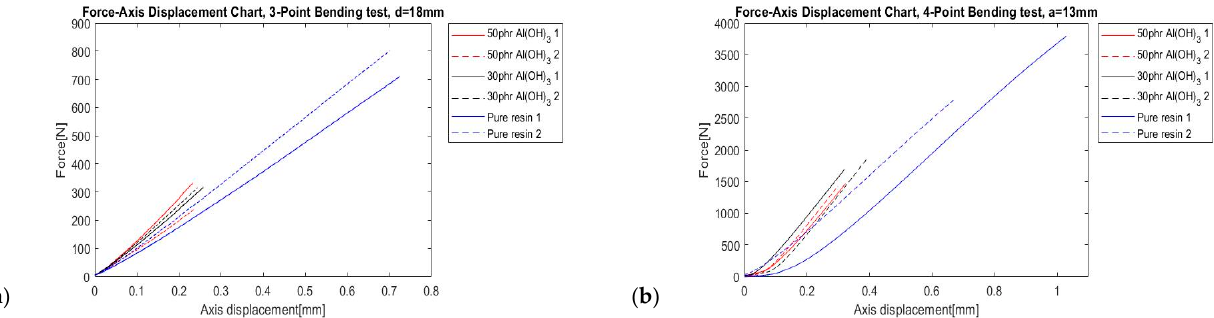
Figure 4. Reference load–displacement curve at the loading point ( a ) 3PBT ( b ) A4PBT.